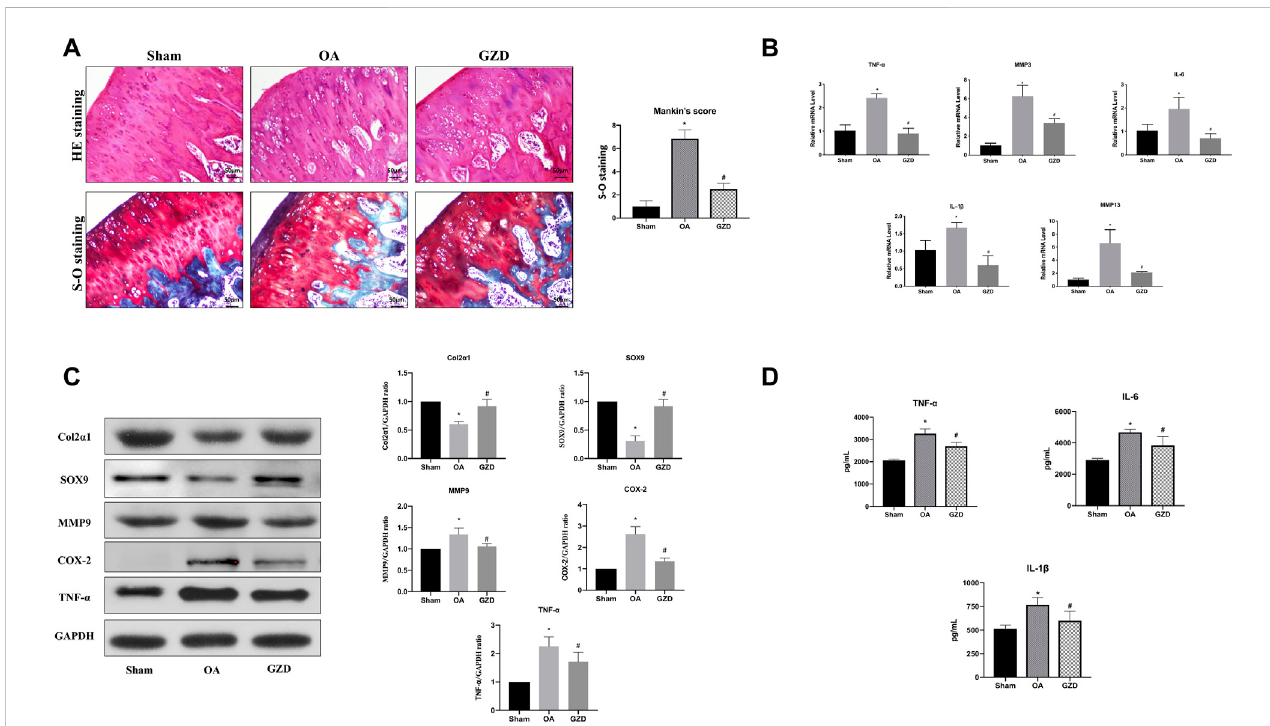
FIGURE 5 GZD ameliorated OA development in vivo . (A) Representative S-O staining and H&E staining of cartilage from the different experimental groups at 4 weeks post-surgery (scale bar = 50 µm), and the diagram shows the Mankin scores of the cartilage. (B) In fl ammatory gene expression assessed via qPCR, with GAPDH for normalization. (C) Representative WB of the TNF signaling pathways and gene levels normalized to GAPDH expression in vivo . (D) Levels of TNF- α , IL-6, and IL-1 β in the serum. Data are mean ± SD from three independent experiments. * p < 0.05 vs. Sham group; # p < 0.05 vs. OA